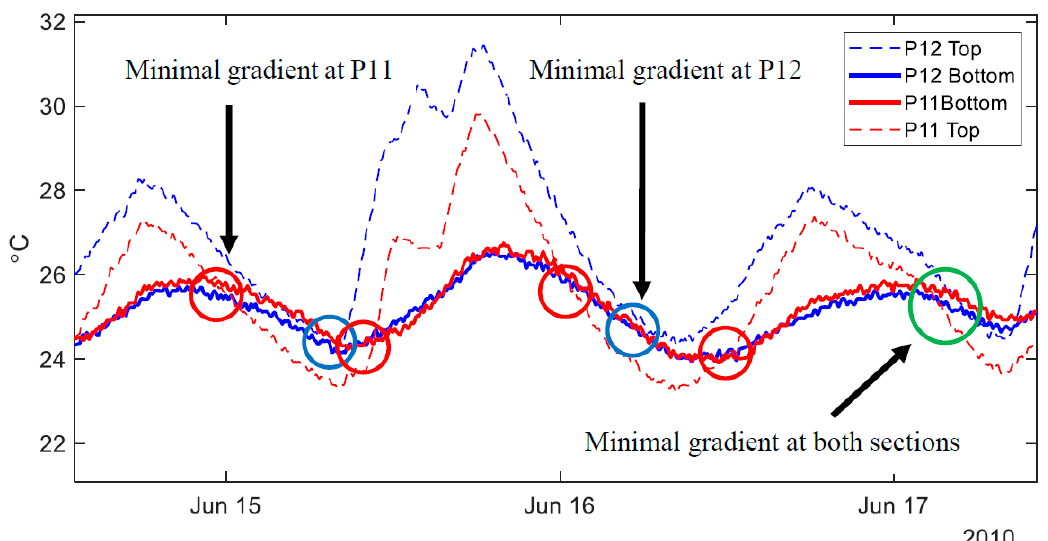
Figure 6. Example of temperature variation over two days in two cross-sections of Streicker Bridge (top and bottom sensors in cross-sections at P11 and P12).